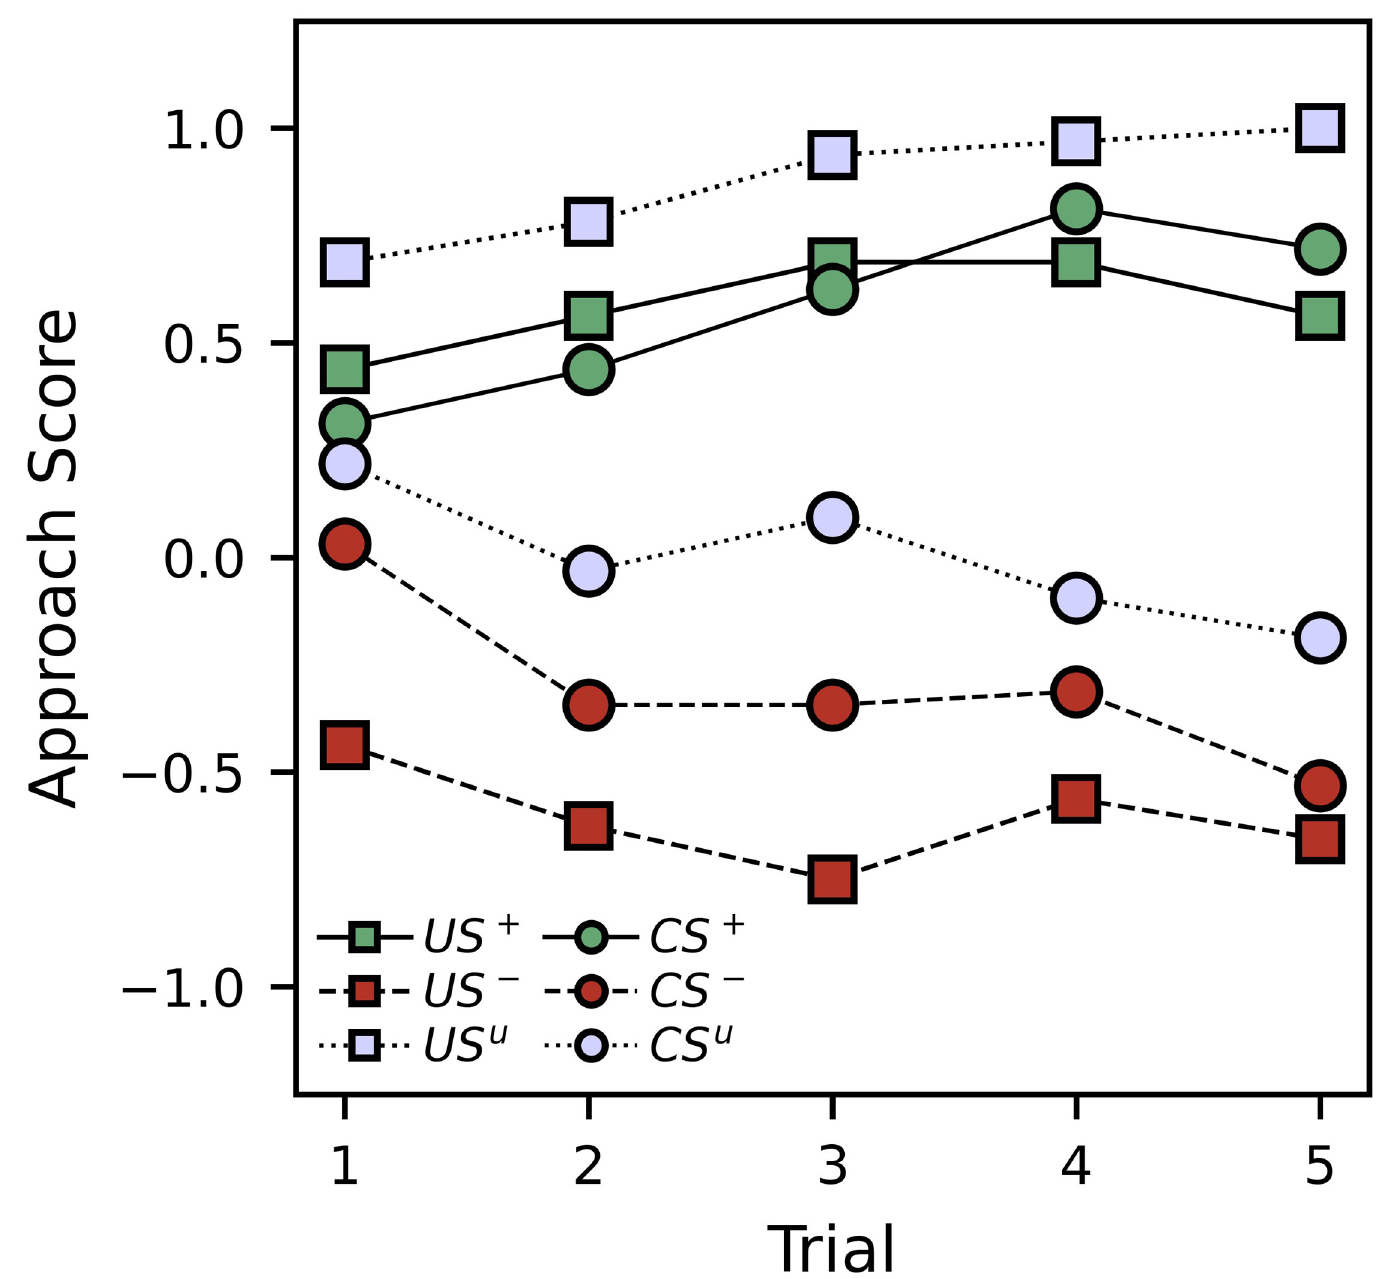
Fig 2. Experiment 1 average approach scores in response to the US and CS for the paired and unpaired groups, divided trial type, during the conditioning trials. Positive approach scores indicate moving or rotating toward a stimulus, negative approach scores indicate moving or rotating away from a stimulus, and zero approach scores indicate no